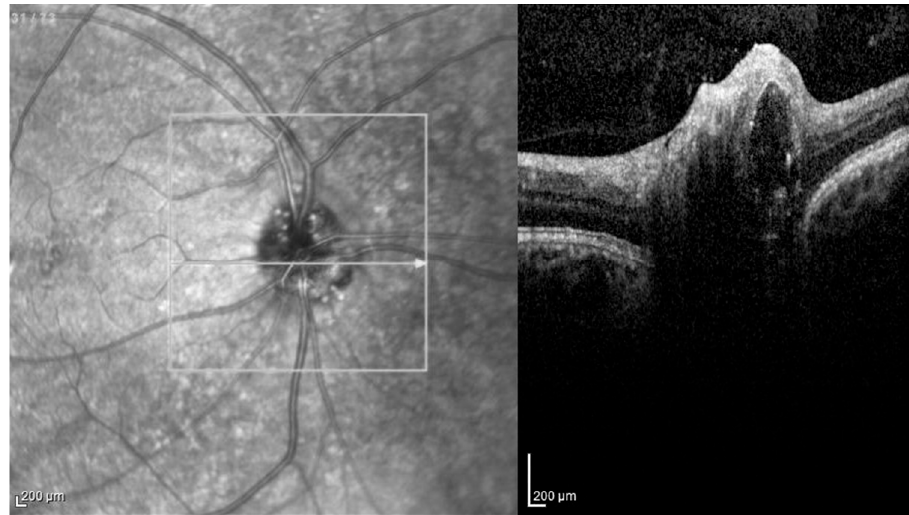
Figure 3. Optical coherence tomography: Large optic disc drusen, visible as a hypo-reflective structures with a total or partial hyperreflective margin, as described by the Optic Disc Drusen Studies (ODDS) Consortium. The hyperreflective margin is often more evident superiorly and can be difficult to detect.